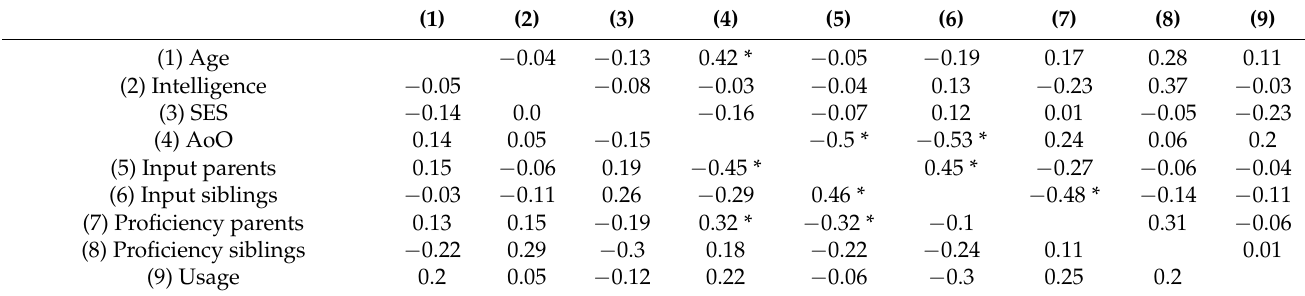
Table 3. Spearman correlation coefficients for Russian (below diagonal) and Turkish children (above